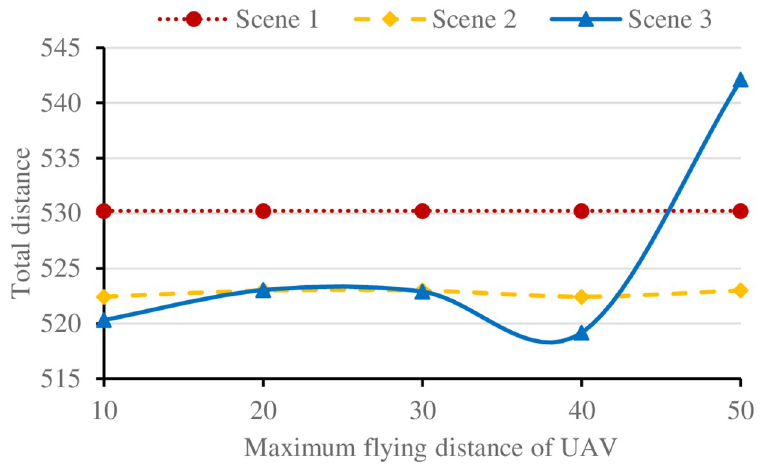
Fig 8. Results of the three scenarios under different flight